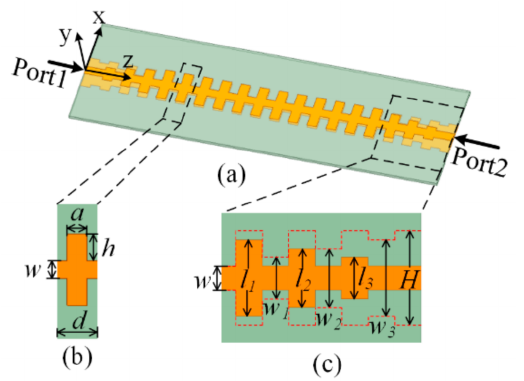
Figure 1. The profile of the parallel SSPPs-TL. ( a ) the full view, ( b ) a unit cell, ( c ) a transition section. d = 6 mm, a = 3 mm, w = 2.7 mm, h = 4 mm, H = 10.7 mm, l 1 = 8.7 mm, l 2 = 6.7 mm, l 3 = 4.7 mm, w 1 = 4.7 mm, w 2 = 6.7 mm, w 3 = 8.